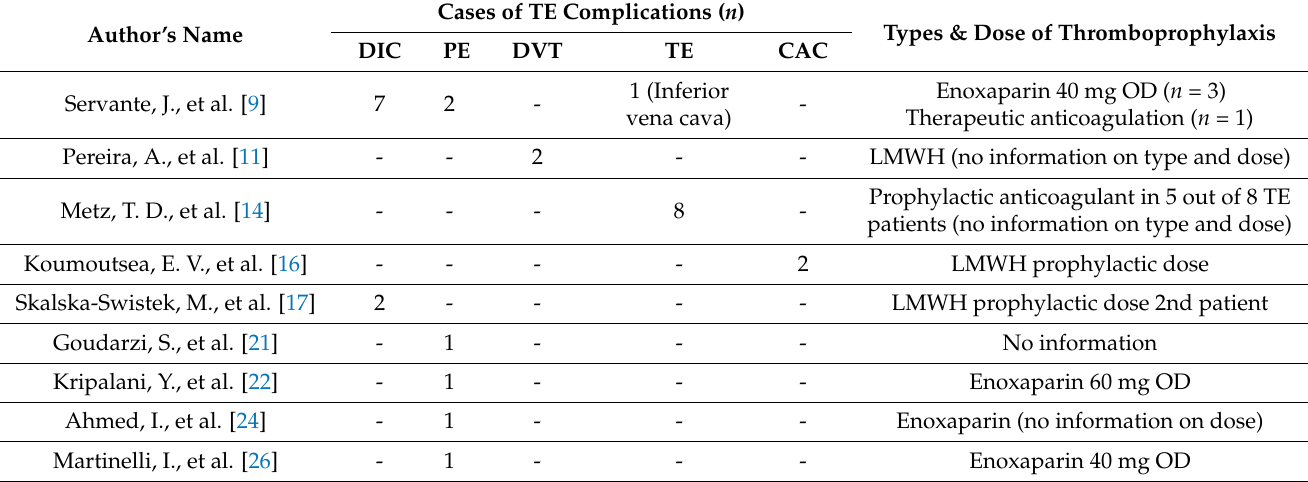
Table 6. Thromboprophylaxis used among COVID-19 infected pregnant women with TE complica-